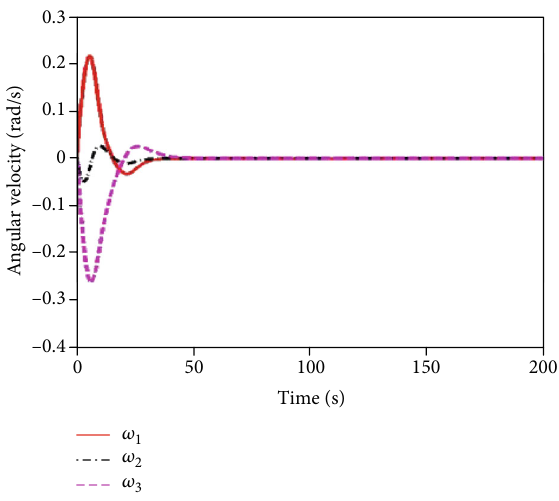
Figure 13: Time histories of fi lter vector in Case 2.